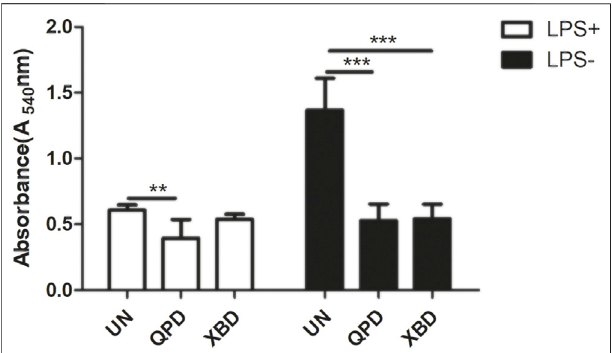
FIGURE 5 | QPD and XBD inhibited pinocytosis activity of THP-1 macrophages. M0 THP-1 macrophages were treated with QPD or XBD (5%, v/v) for 24 h and then stimulated with or without 1 µg/ml LPS and 20 ng/ml IFN- γ for another 24 h before neutral red uptake assay. LPS+, treated with LPS and IFN- γ ; LPS-, treated without LPS and IFN- γ . ** p < 0 . 001; *** p < 0 . 001 compared with UN or as